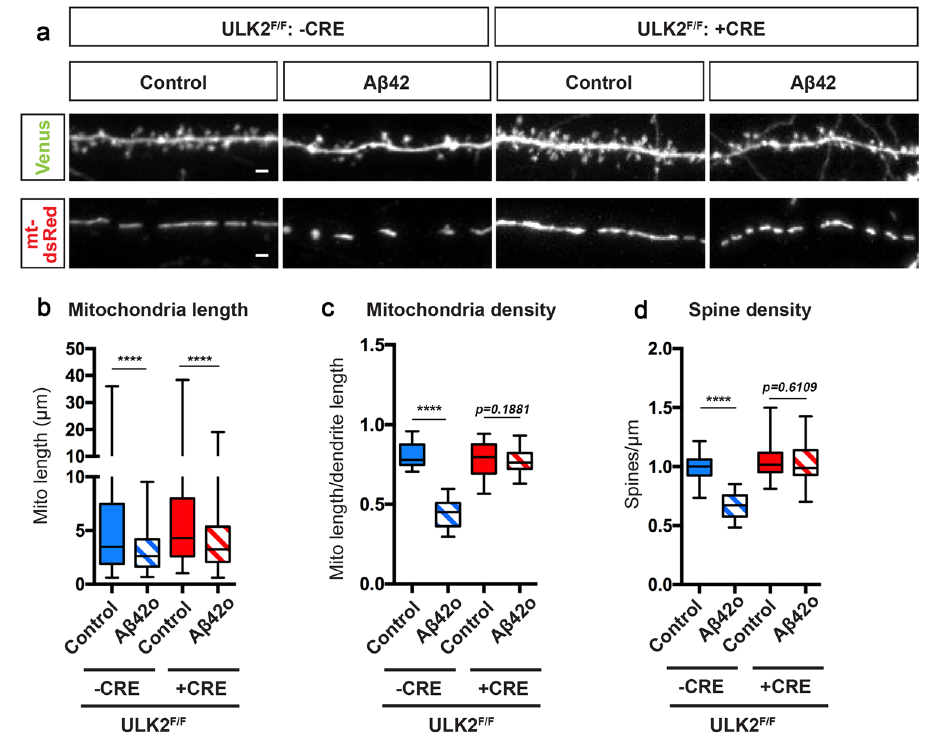
Fig. 8 | ULK2 acts in a concerted manner with MFF and leads to loss of mito- chondrial biomass following MFF-dependent mitochondrial fragmentation. a Representative images of secondary dendritic segments of primary cortical PNs at21DIV.ULK2 F/F embryos were ex utero electroporated atE15.5 with pCAG-Venus, pCAG-mito-DsRed, and without (-Cre) or with pCAG-Cre recombinase (+Cre). Neurons were treated at 20 DIV with either a vehicle control or A β 42o for 24h. DeletionofULK2incorticalPNsblocksA β 42o-inducedlossofdendriticspinesand loss of mitochondrial biomass, but does not prevent a decrease in mitochondrial length. b – d Quanti fi cation of b dendritic mitochondrial length, c dendritic mito- chondrial density, and d dendritic spine density. Analyses were done blind to the